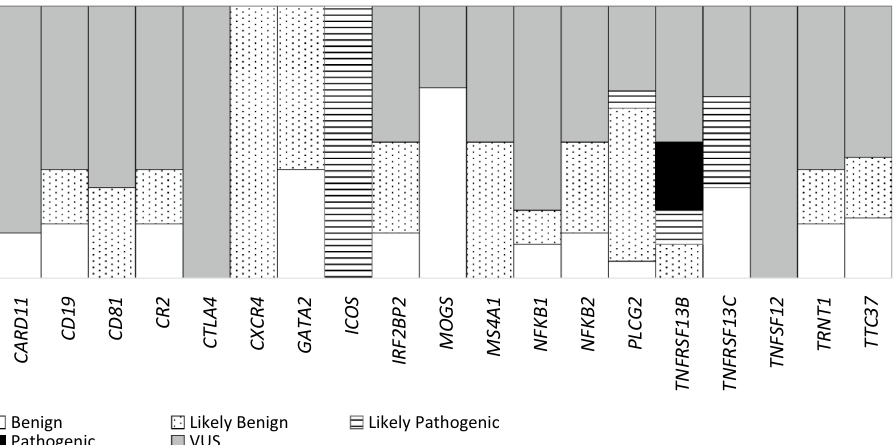
Figure 2. Distribution of the rare variants. Pathogenicity from benign to pathogenic are given accordingly with the ACMG criteria. The well-known pathogenic variants that have > 10% population frequency have been excluded while the pathogenic variants shown here are the ones with differential effects in different populations.